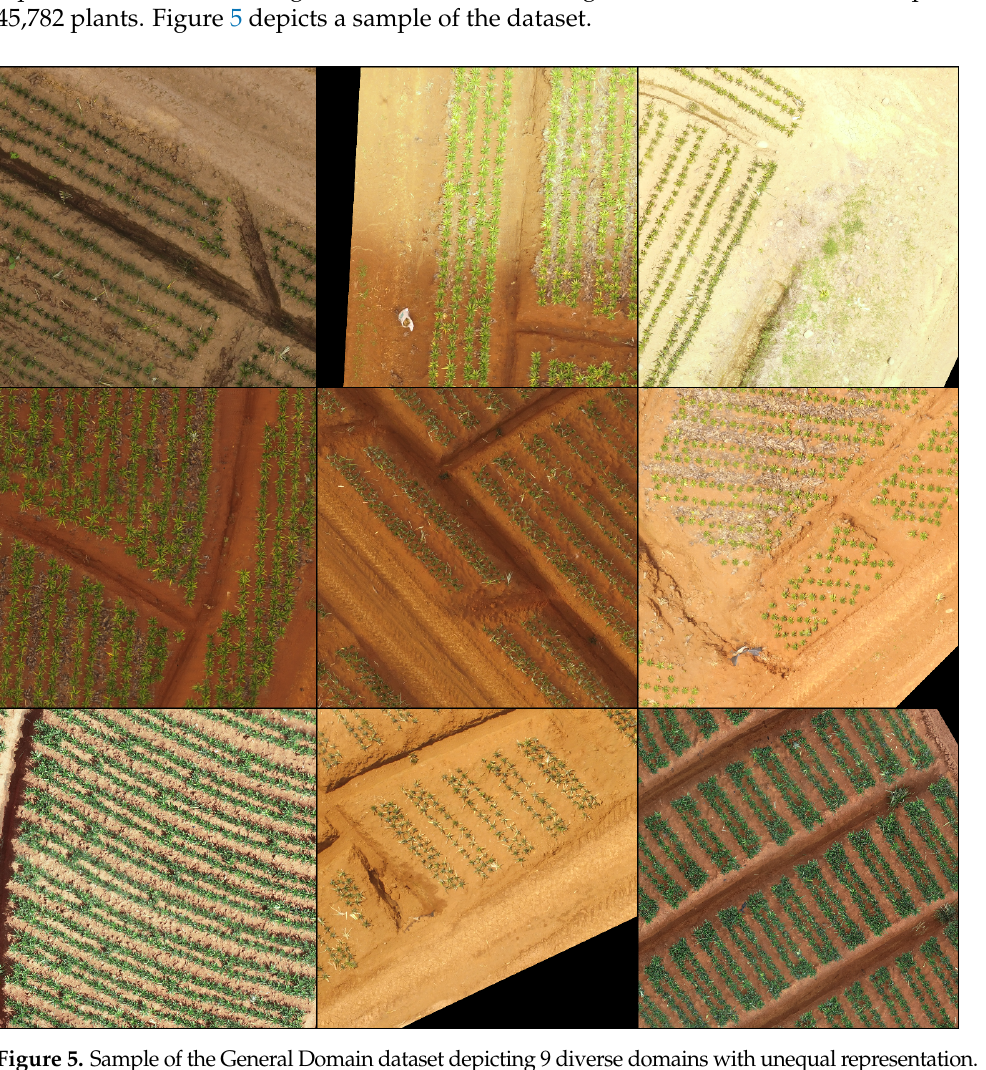
Figure 5. Sample of the General Domain dataset depicting 9 diverse domains with unequal